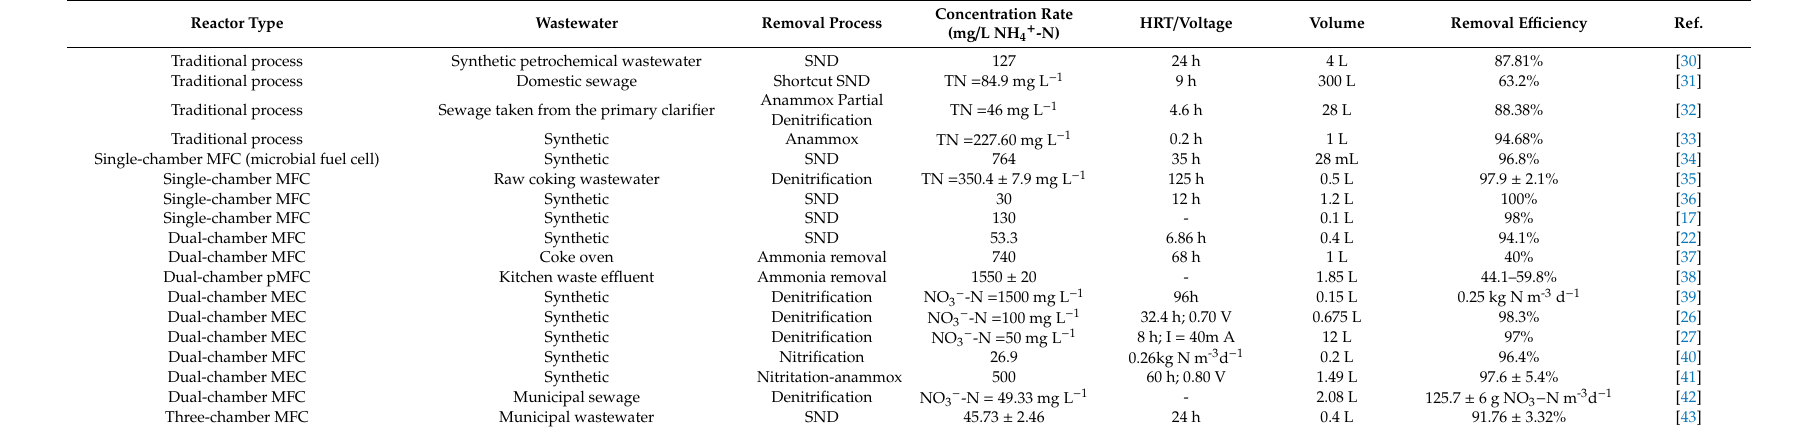
Table 2. Removal of nitrogenous contaminant via di ff erent